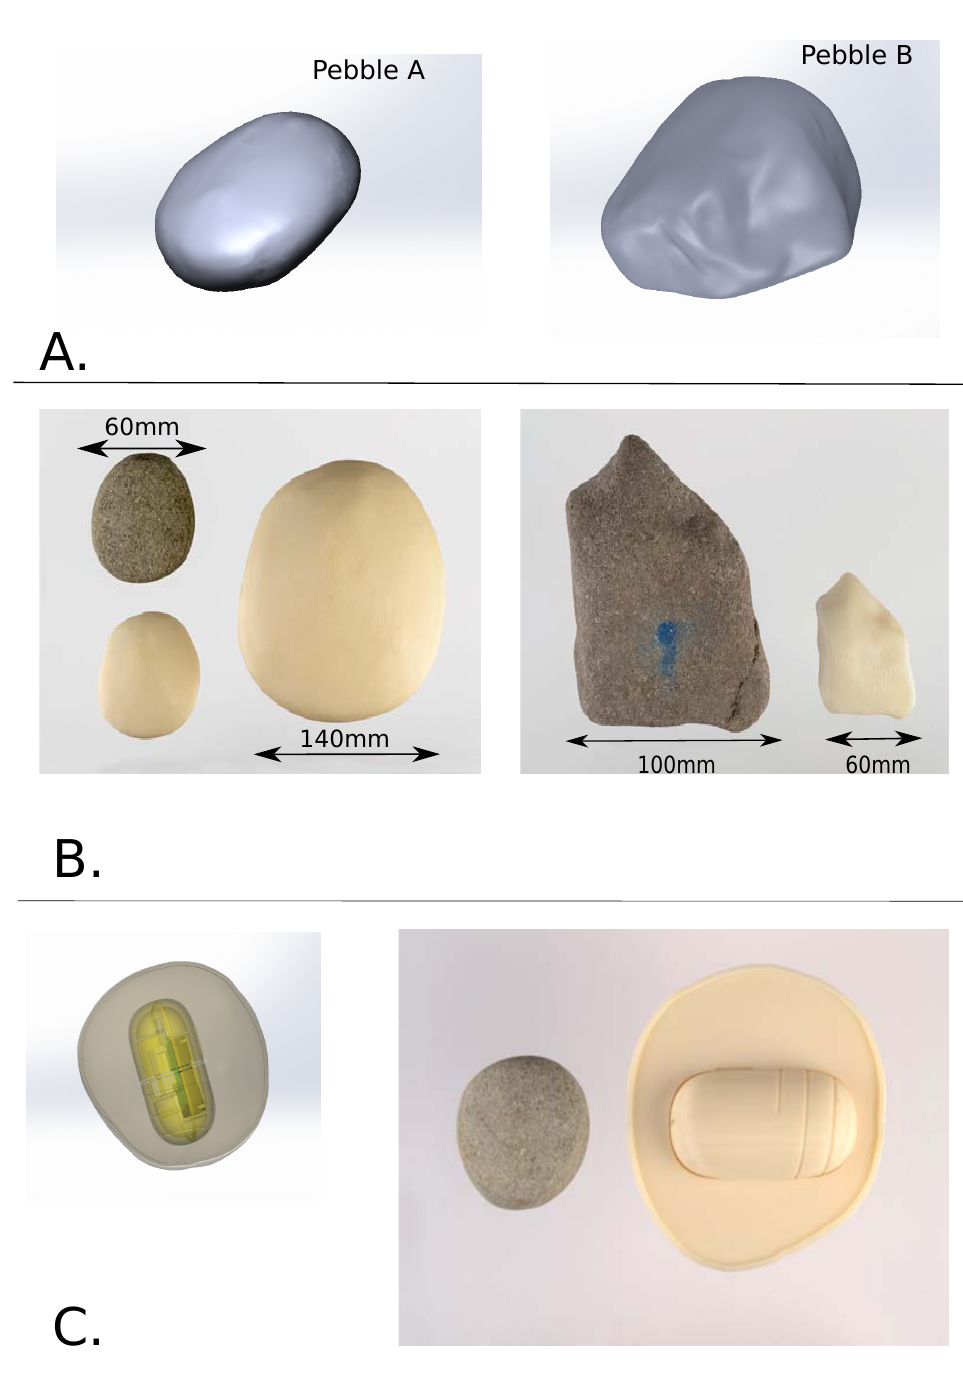
Figure 4. Scaled copies of natural stones and representative example case: ( A ) 3D designs of natural stones after processing the data from the 3D scanner. Note the differences in angularity and sphericity (Pebble A is blade-shaped with medium sphericity; Pebble B is compact and platy with low sphericity); ( B ) Scaled 3D printings of Pebble A ( left ) and Pebble B ( right ); ( C ) Outer case based on Pebble A. The internal structure incorporates the internal case for the G-node. This outer case has a simple internal structure, but more complicated internal designs, such as used for the spherical cases, can be incorporated (Figure